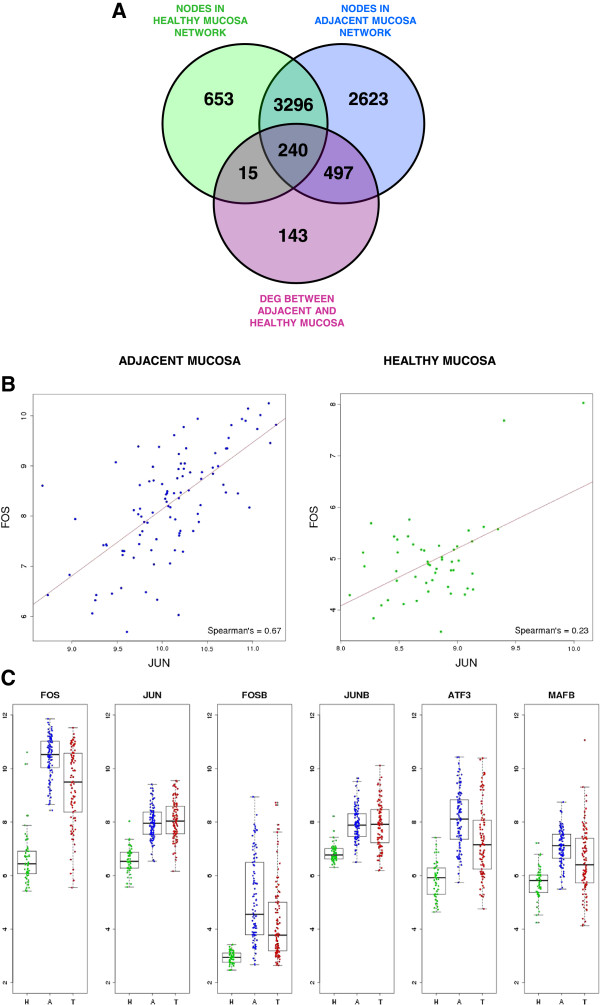
DEG analysis in the framework of transcriptional networks. A. Venn Diagram showing the overlap between nodes in adjacent mucosa transcriptional network (blue) and healthy mucosa transcriptional network (green). DEG were merged with the two transcriptional networks. B. Expression correlation between transcription factors Jun and Fos in adjacent (blue) and healthy mucosa (green). C. Gene expression levels of AP-1 subunits in healthy mucosa (green) adjacent mucosa (blue) and tumor tissue (red).